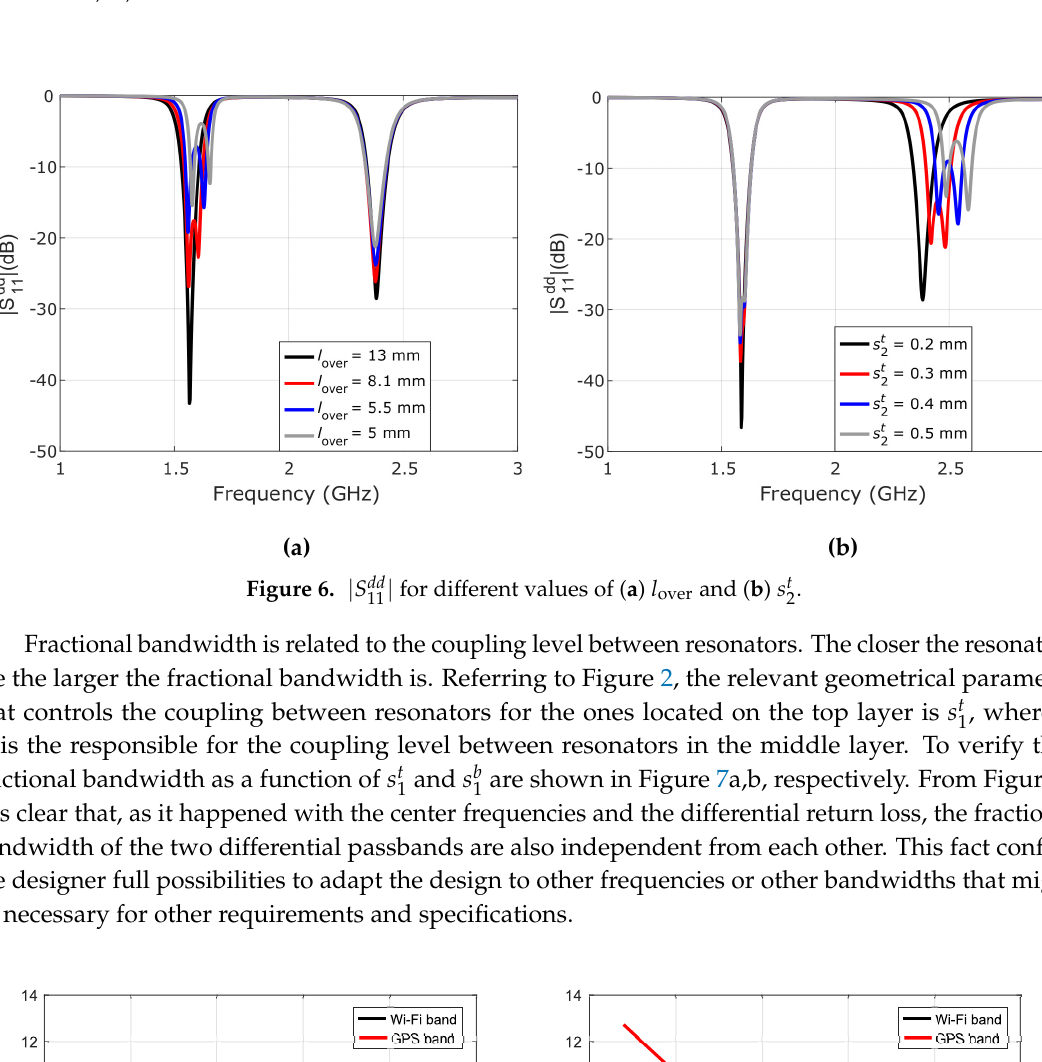
is adjusted; ( b ) s b is 1 1